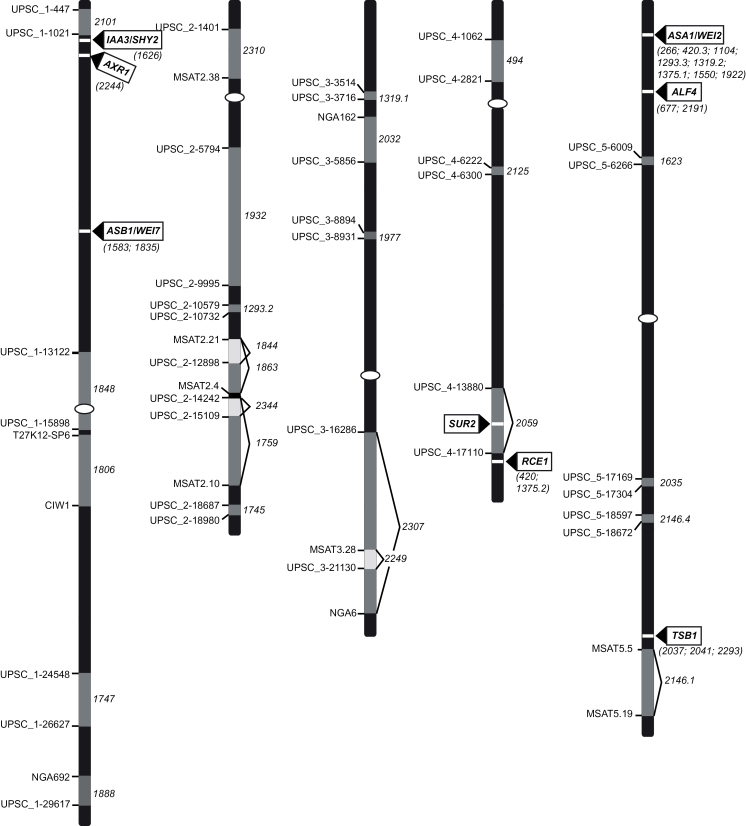
Chromosomal localization of sur2-1 suppressor mutations. From left to right: chromosomes 1, 2, 3, 4, and 5. Black indicates chromosomes; horizontal white bars indicate the positions of identified suppressor genes, whose names are indicated in boxes with arrows; numbers in brackets indicate alleles. Light and dark grey boxes indicate regions containing the mutations (numbers on the right of the chromosomes) that still need to be identified, each flanked by two indel markers (identified on the left of the chromosomes).